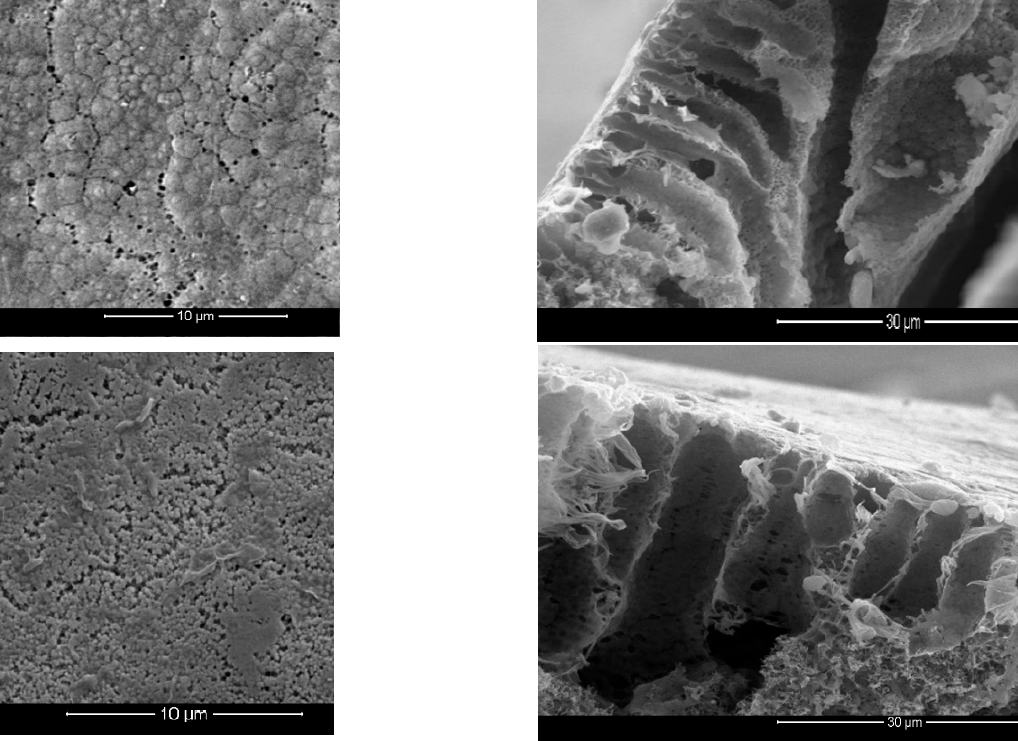
Table 4. Membranes’ top layer pore size and